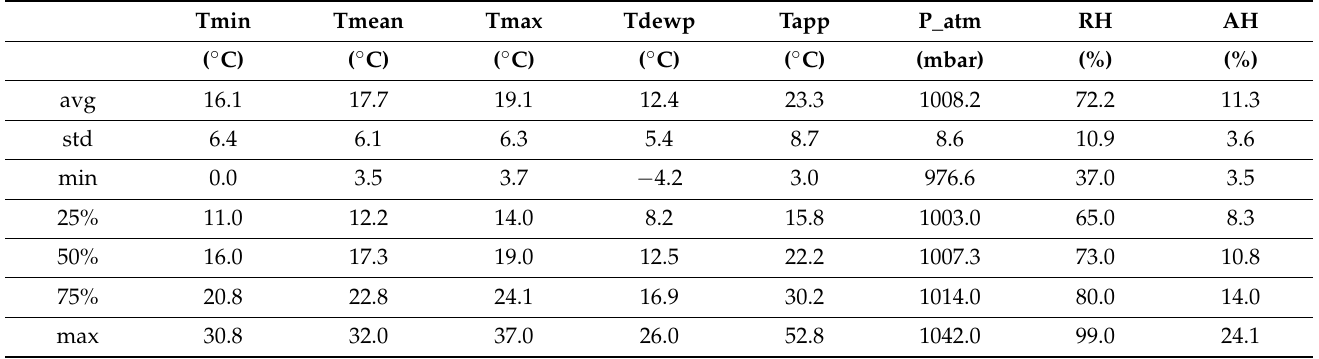
Table 6. Descriptive data statistics. Legend: avg = average; std = standard deviation; 25%, 50%, and 75% = 25th, 50th, and 75th percentiles, respectively; min–max = range.